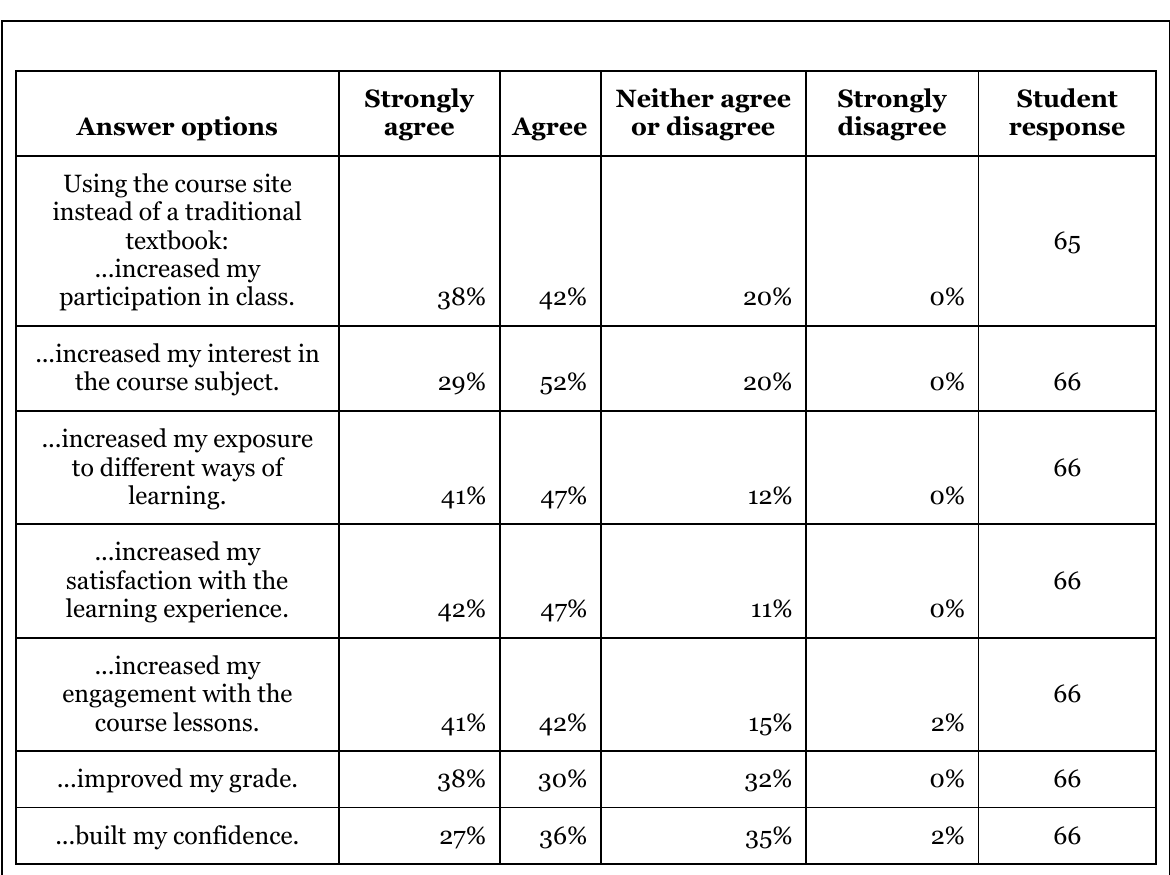
Level of Agreement About How the OER Impacted the Learning Experience (n=66)